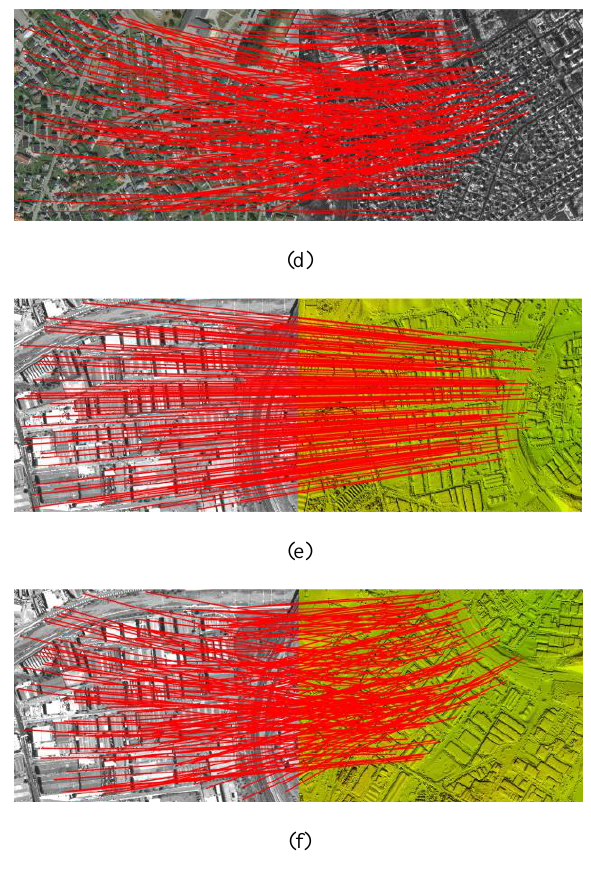
Figure 9. Matching results of the proposed method. (a)-(f) are the matching results of image pairs 1-6,